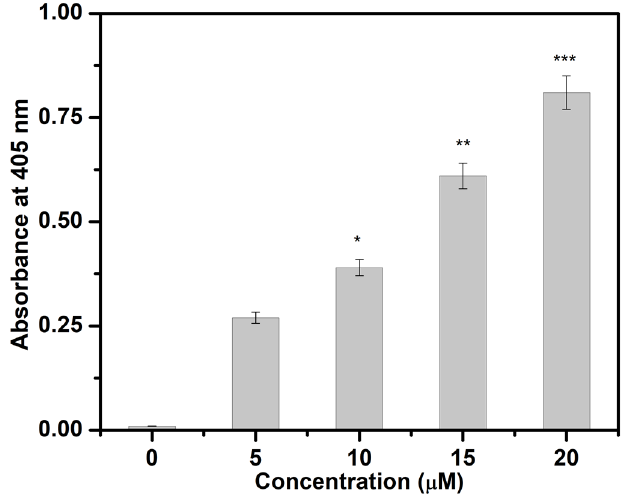
Figure 10. DNA fragmentation assay of complex 1 (0–20 μ M)-treated HCT 116 cancer cells. Value of each experiments taken three times ( n = 3) (* p = 0.05, ** p = 0.01, *** p = 0.001) compared with control.